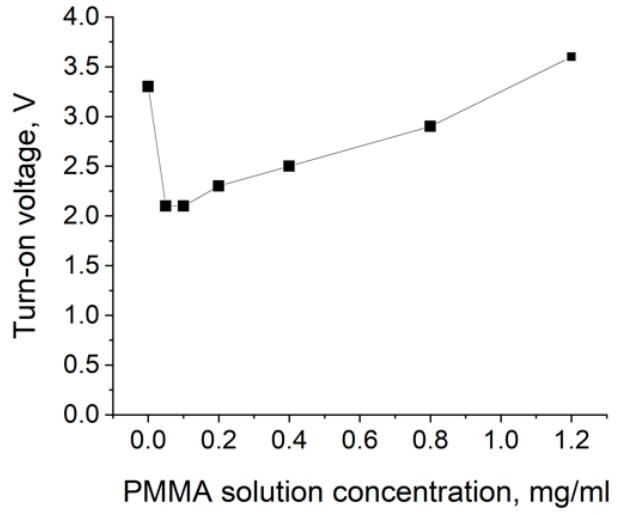
Figure 3. Effect of PMMA solution concentration on the turn-on voltage value of the QDLED device.